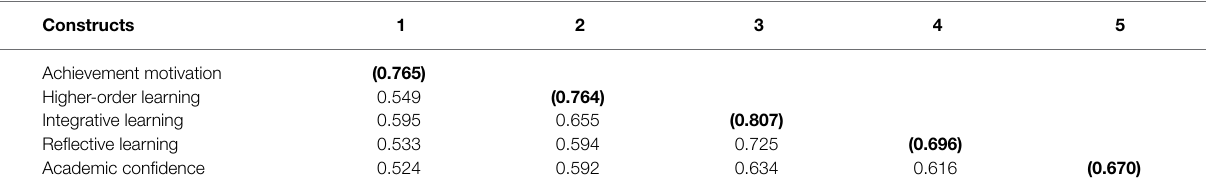
TABLE 4 | Construct discrimination